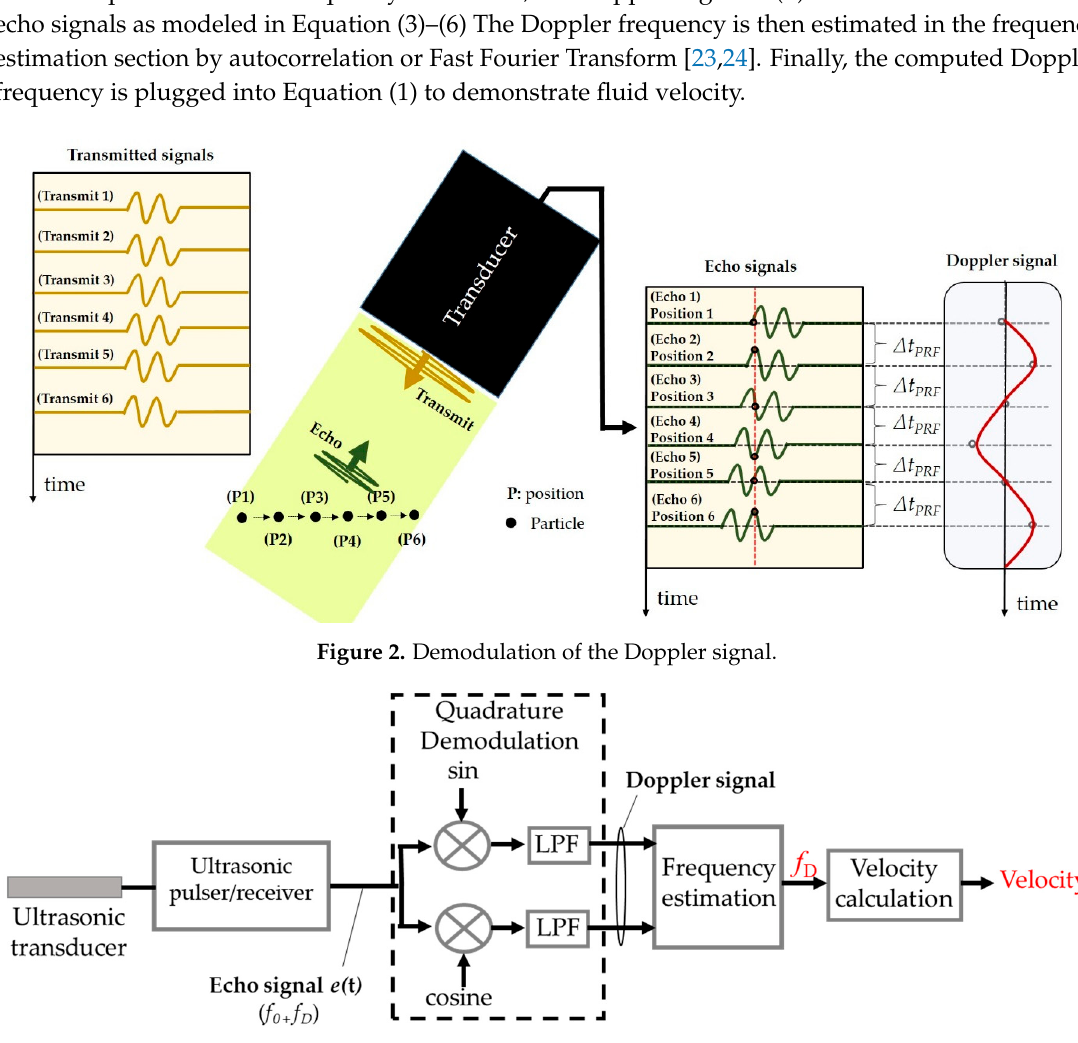
Figure 3 . Block diagram of the UVP system based on the Doppler pulse repetition technique.